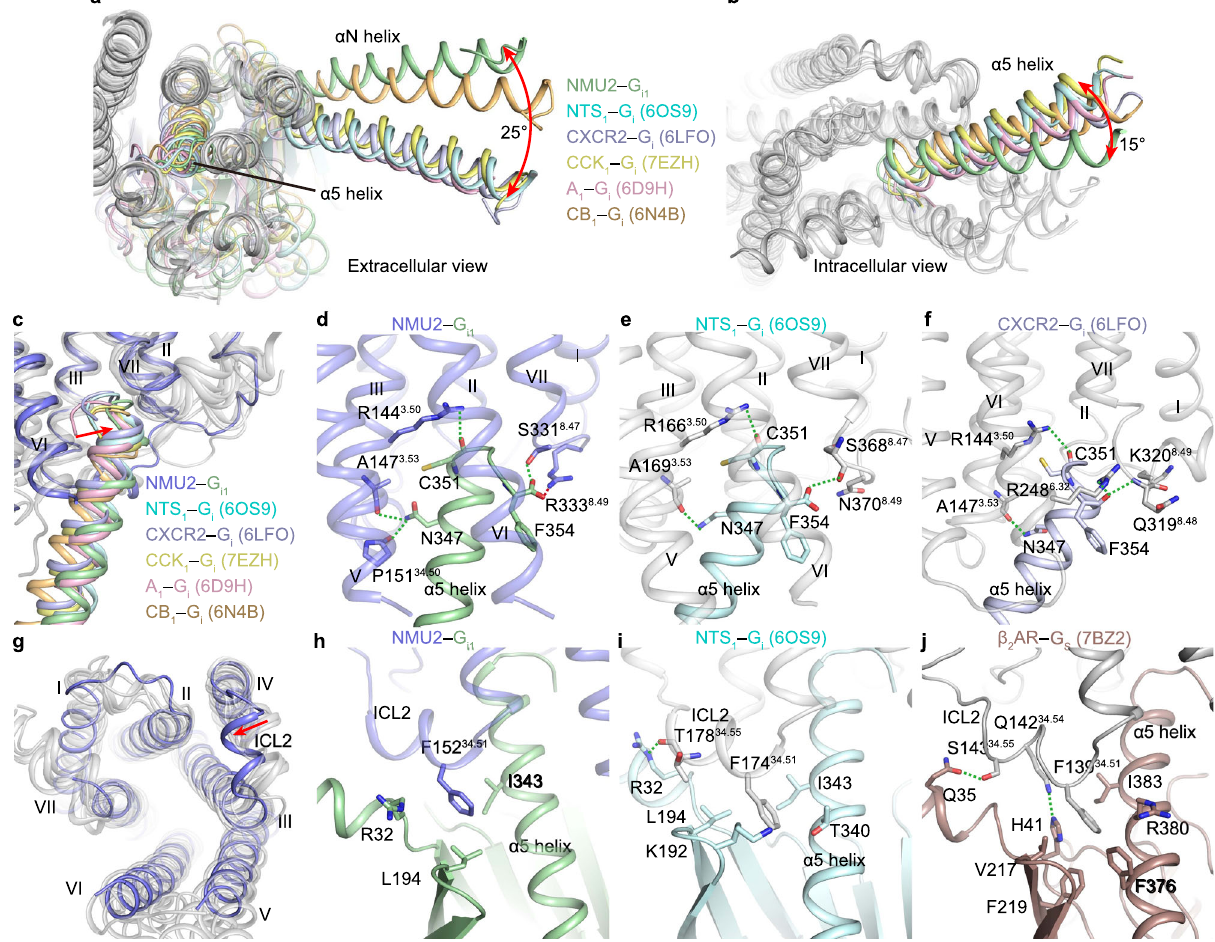
Fig. 4 | Comparison of G protein coupling of NMU2 – G i1 complex. a , b Comparison of the G protein binding pose in NMU2 – G i1 , NST 1 – G i (6OS9), CXCR2 – G i (6LFO), CCK 1 – G i (7EZH), A 1 – G i (6D9H) and CB 1 – G i (6N4B) complexes. G α i in NMU2 – G i1 , NST 1 – G i , CXCR2 – G i , CCK 1 – G i , A 1 – G i , and CB 1 – G i complexes are shown as cartoon and colored by pale green, pale cyan, blue-white, pale yellow, lightpink,and wheat.G β and G γ are not displayedforclarity. Receptorsare shown as a gray cartoon. Conformational changes of α N helix ( a ) and α 5 helix ( b ) are indicated by red arrows. c Comparison of the α 5 helix of G i in the NMU2 – G i1 and other GPCR – G i complexes. NMU2 is shown as a slate cartoon, and other receptors